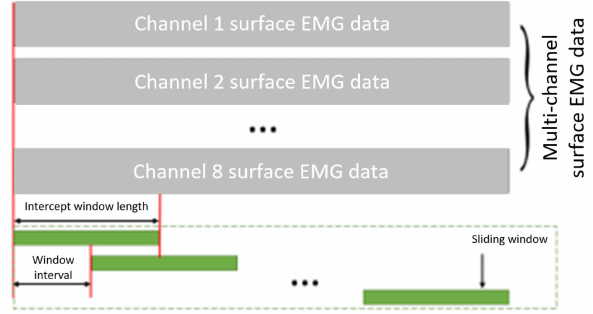
Figure 4. Sliding window method to extract the feature